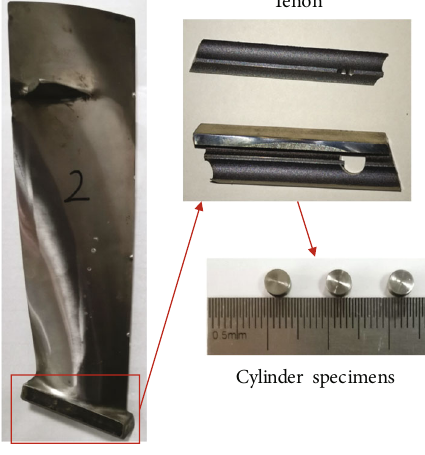
Figure 2: Specimens used in the SHPB